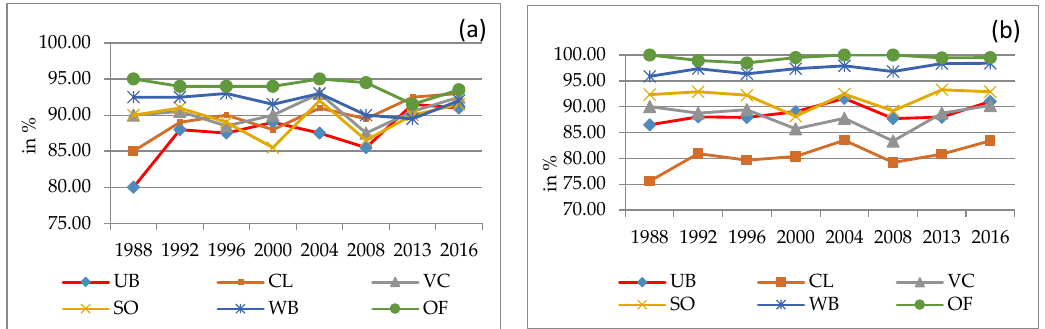
Figure 3. Accuracy assessment ( a ) user’s accuracy; and ( b ) producer’s accuracy.